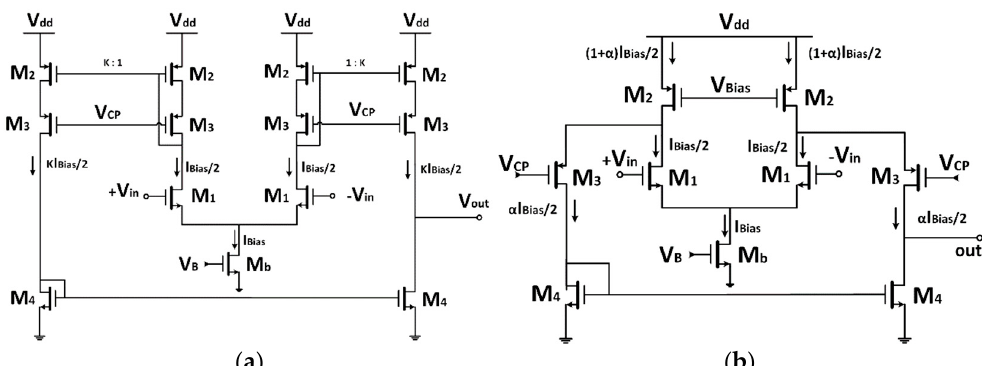
Figure 2. Core: ( a ) Mirrored OTA; and ( b ) Folded Cascode OTA.